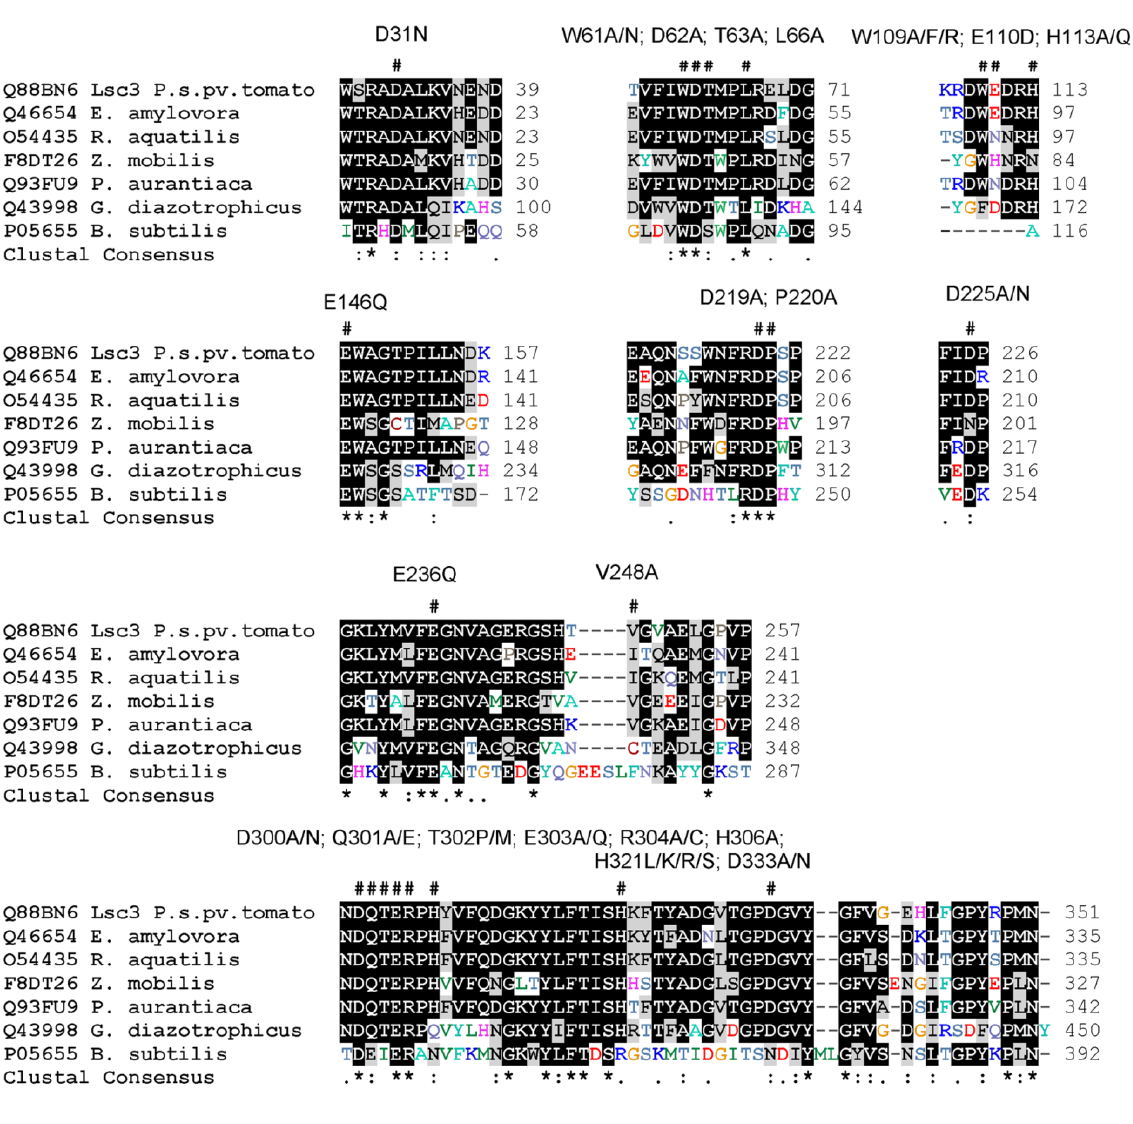
alignment of levansucrases from Pseudomonas syringae pv. tomato (Lsc3),